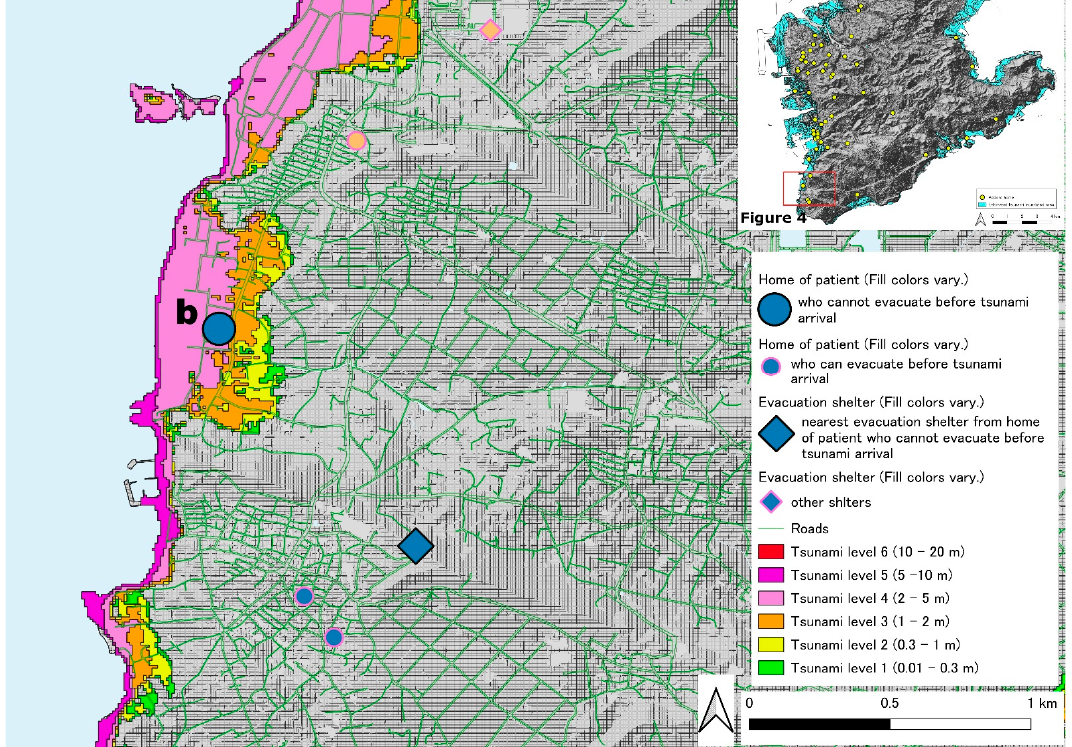
Figure 4. The locations of patients with chronic respiratory disease with HOT who live in the tsu- nami inundation areas on the western coast of the southern part of the main island of Okinawa-2.